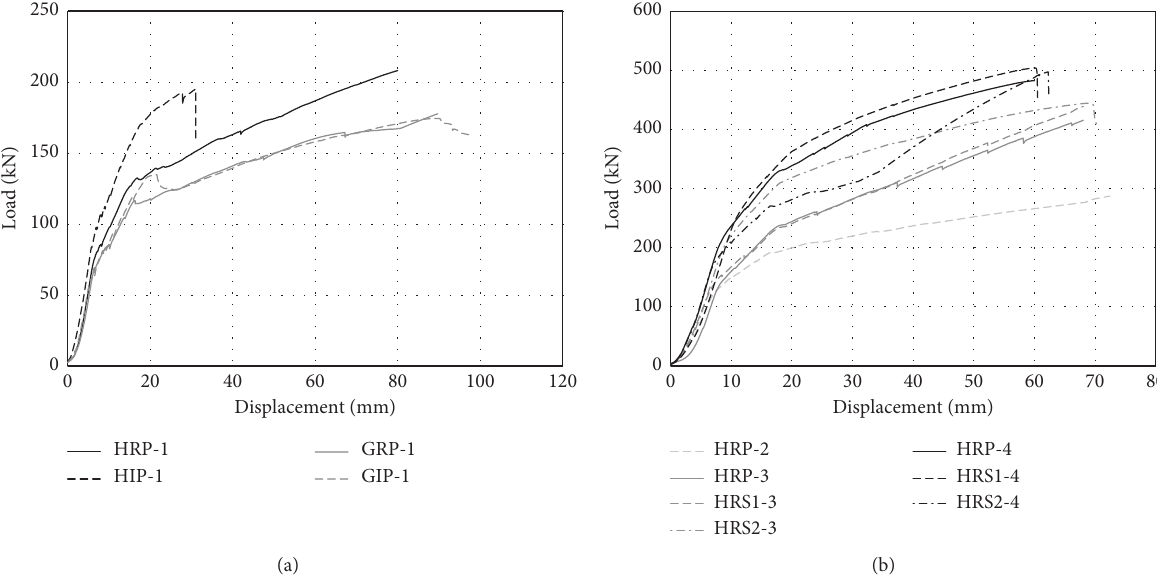
Figure 9: Load-displacement relationship. Comparison of load-displacement relationship for (a) varying cross sections and tensile strengths and (b) varying numbers of strands and anchorage zone reinforcement types.